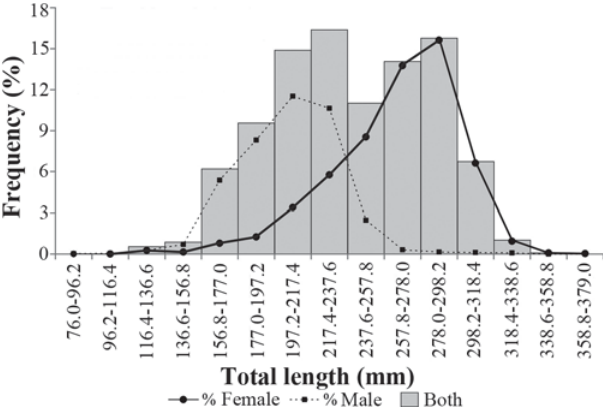
Fig. 2. Frequency of Acestrorhynchus pantaneiro grouped by length classes (mm) (bars) and separated by sex (lines).